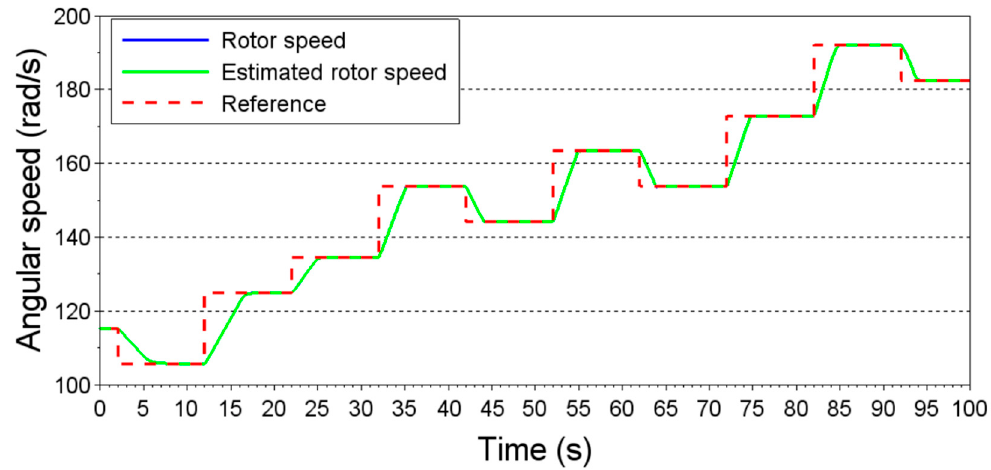
Figure 8. Estimation of rotor speed and its convergence to the reference value.